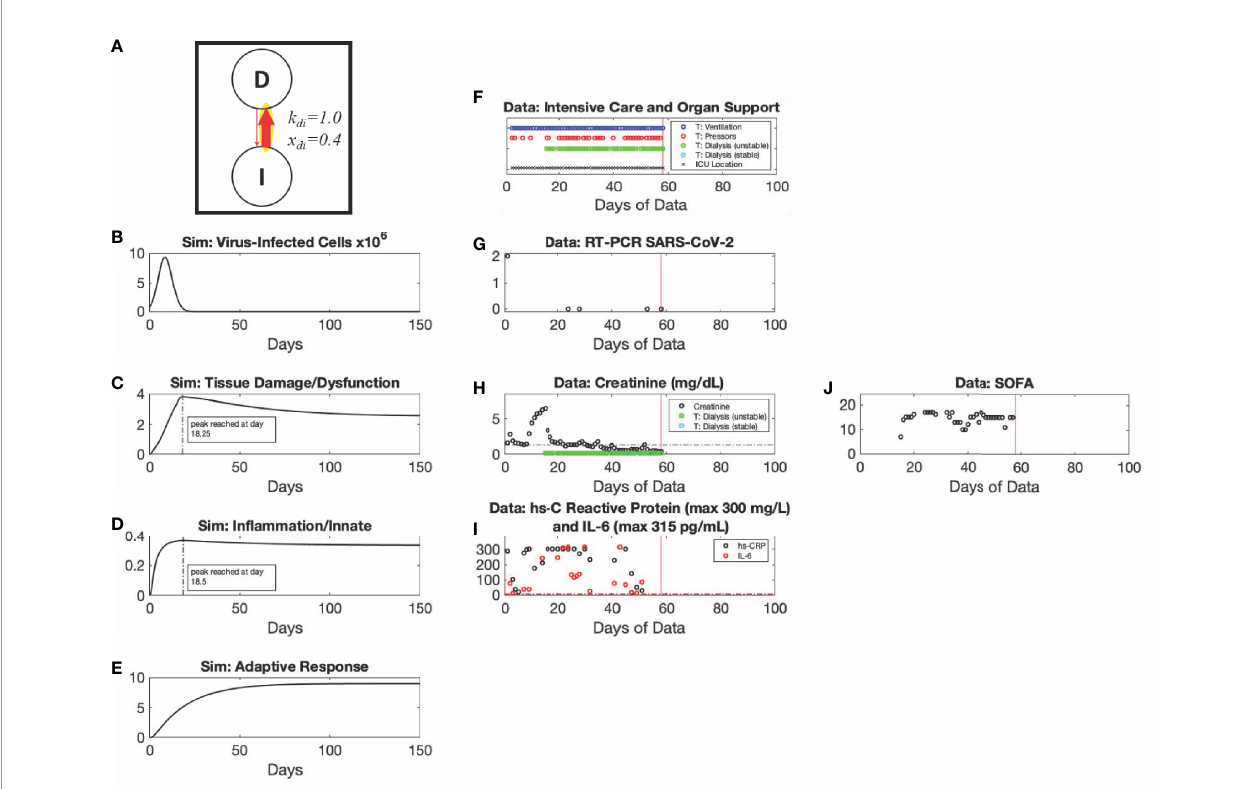
FIGURE 5 | Damage-sustained In fl ammation archetype: simulation vs . patient data. Using modi fi ed values of parameters k di and x di compared to the Recovery archetype, Mild scenario as shown in the diagram (Panel A ), simulated dynamics are shown of C V (Panel B ) (Initialized with a C V =8x10 5 virus-infected cells), D (Panel C ), I (Panel D ), and A (Panel E ). Panels (F – J) show data from a patient in their 50s with diabetes who presented with hypoxemia and increased work of breathing after 6 days of shortness of breath and chest pain at home. The patient was found to be in diabetic ketoacidosis and was intubated the day